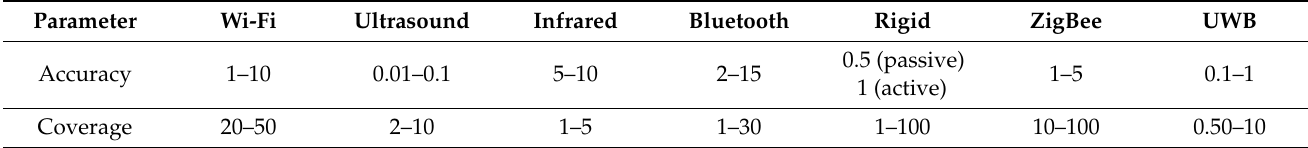
Table 1. Range of accuracy (meters) and coverage (meters) for